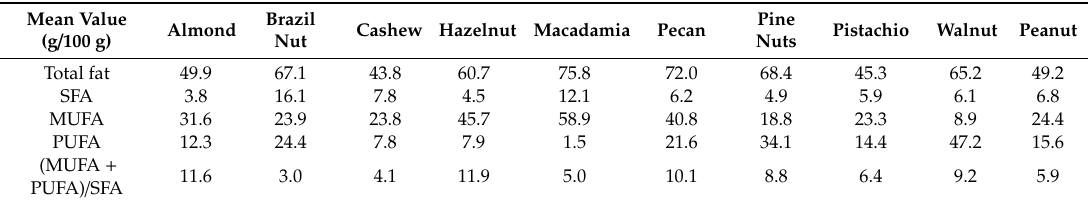
Table 7. Average fat composition of nuts